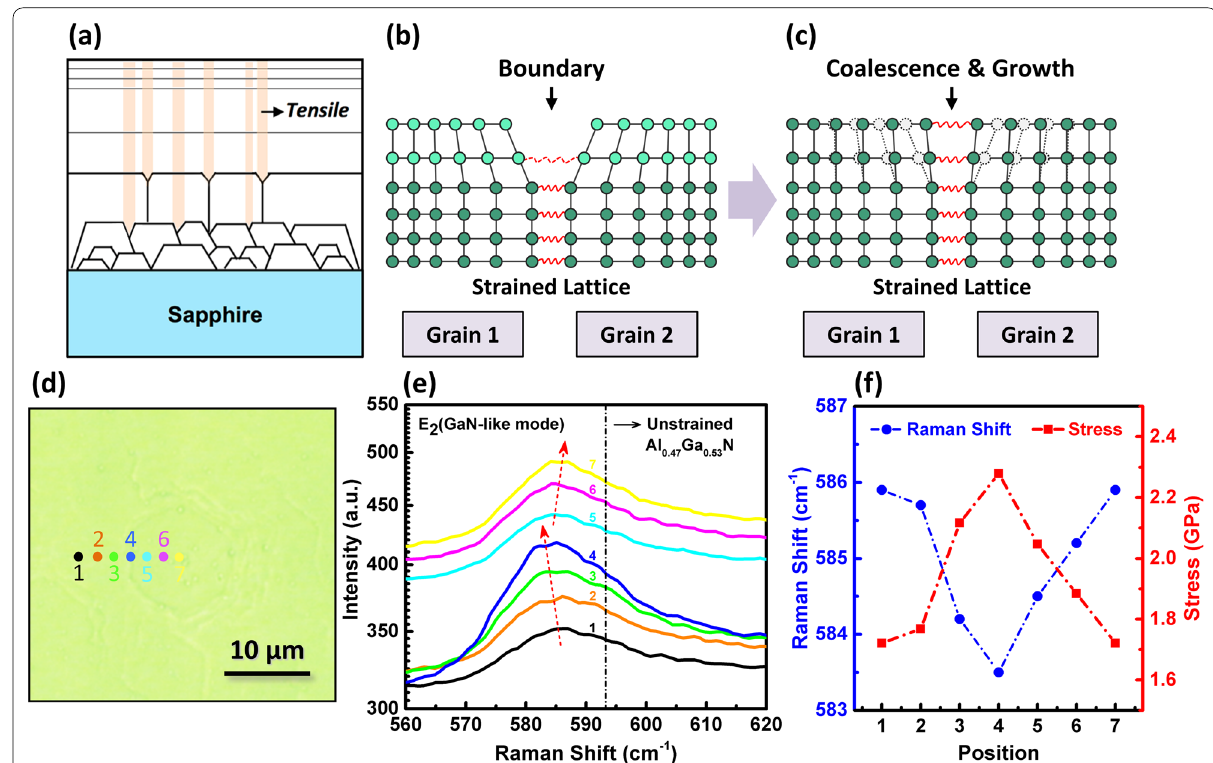
Fig. 4 a Schematic of the tensile strain field in the epitaxial layer. b , c Mechanism of the tensile strain generation and extension with the grain boundary formation and growth. d Optical image of the hexagonal area of MQWs. The seven points indicate the positions for taking Raman spectra. e Raman spectra, f Raman shift of E 2 (GaN-like) mode and calculated stress of the seven